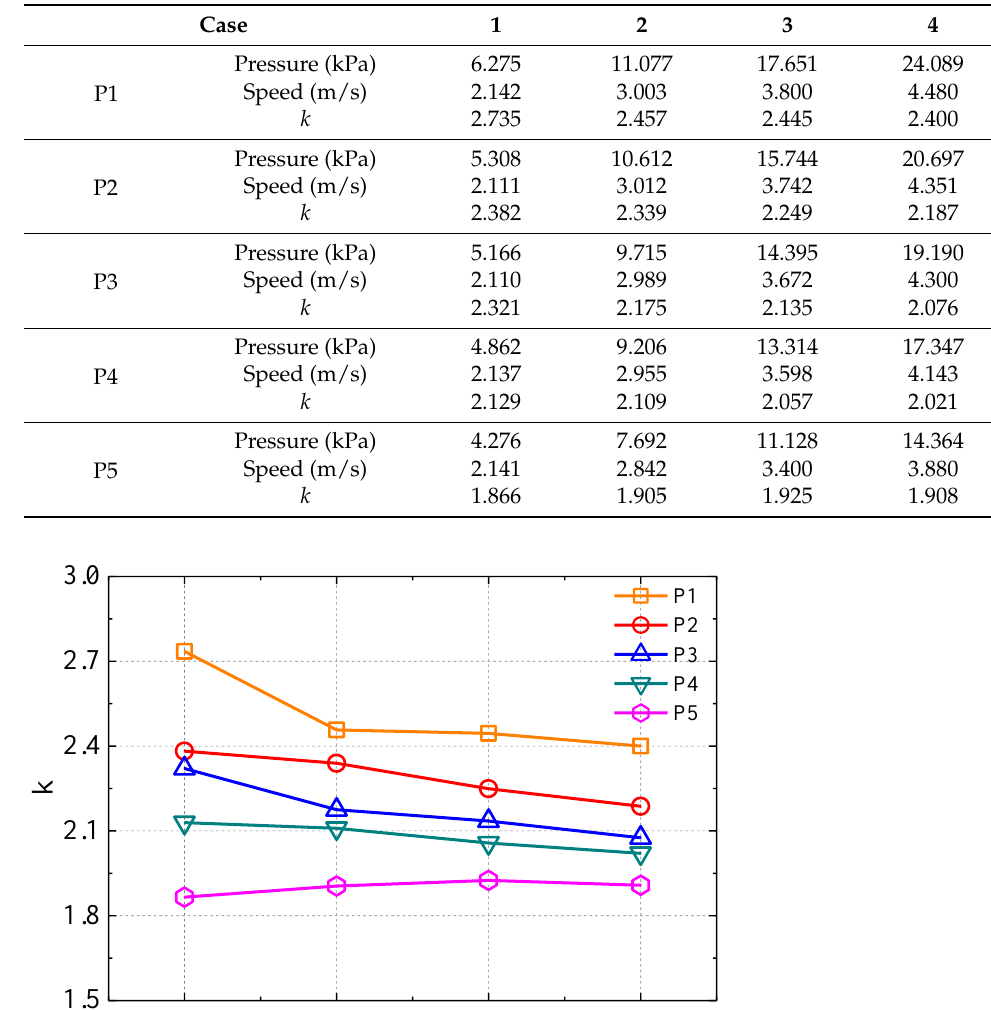
Table 11. Summary of impact pressure results.